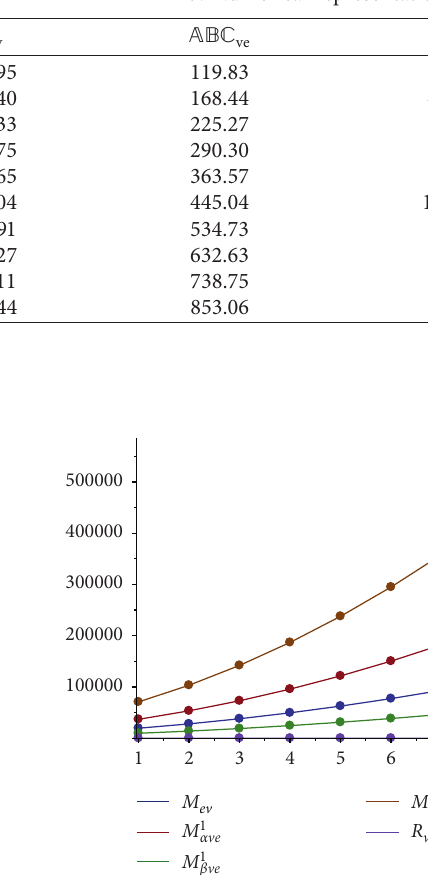
, M 1 , M 1 , M 2 , and R ev α ve β ve ve